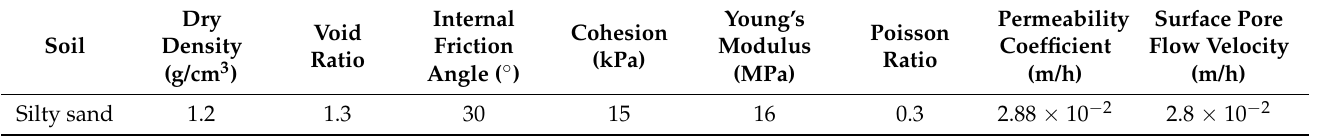
Table 3. Calculation parameters for the numerical model.